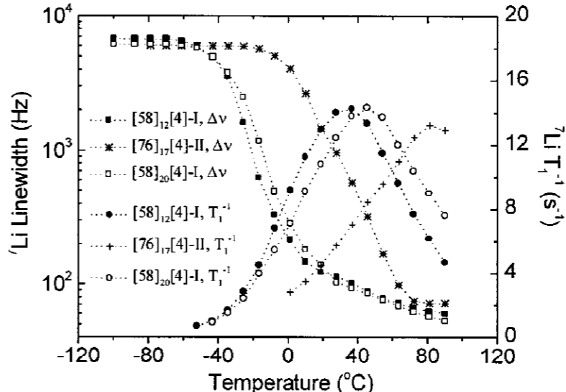
Figure 6. Temperature dependence of the 7 Li spin-lattice relaxation rate and line width without 1 H decoupling for the nanocomposites [58] 12 [4]-I, [58] 20 [4]-I, and [76] 17 [4]-II in Table 2. Reproduced with permission from Mello et al. [76]. Copyright 2000, American Chemical